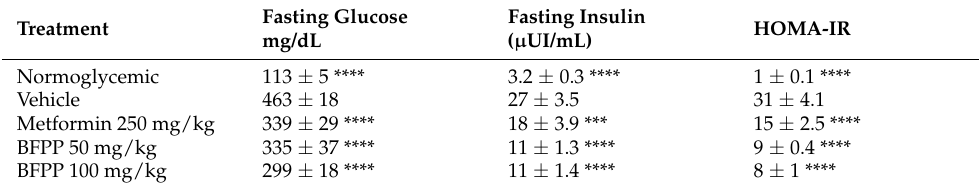
Table 4. Effect of butanol fraction of P. peruviana (BFPP) on fasting glucose, fasting insulin, and HOMA